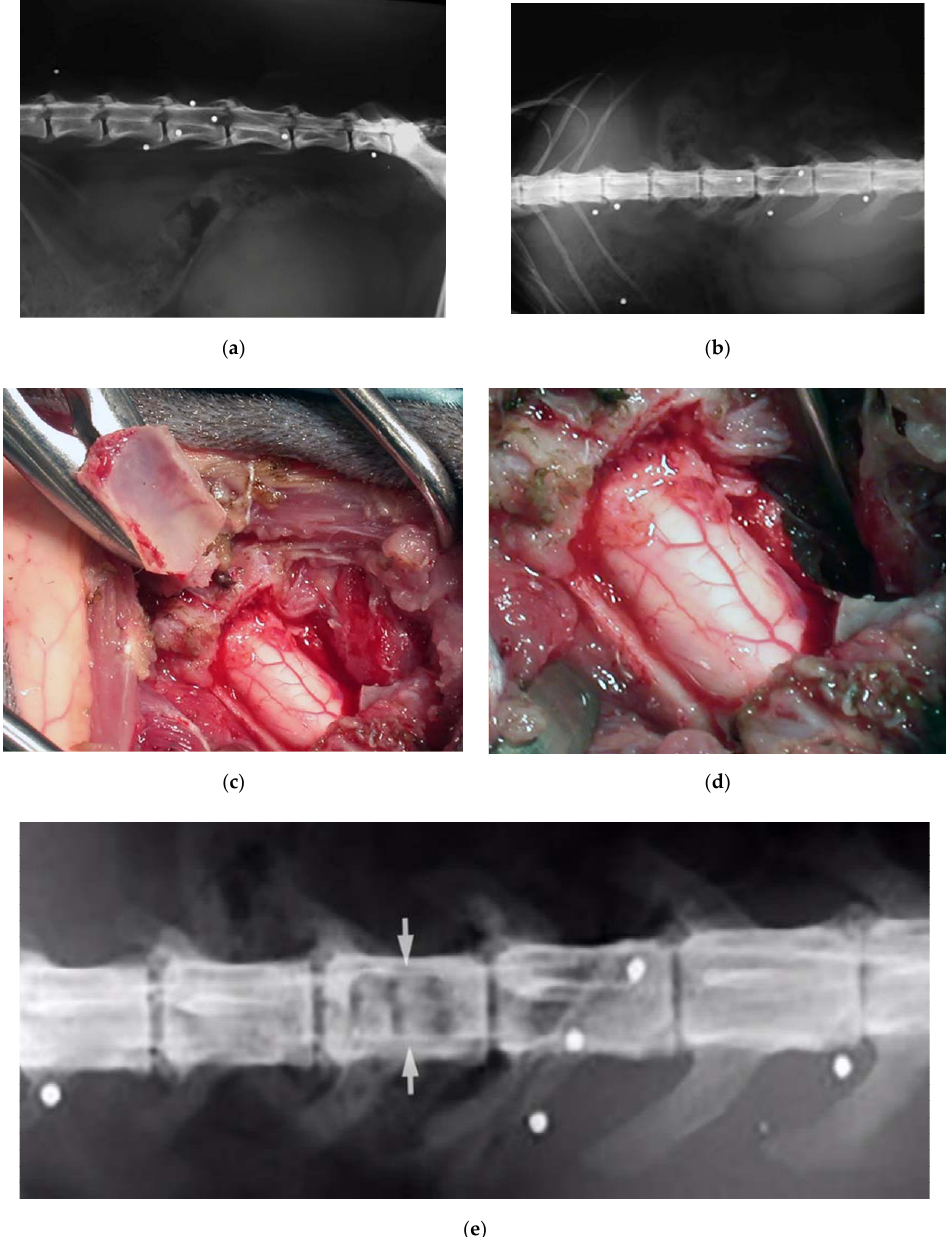
Figure 8. X-ray in latero-lateral ( a ) and ventro-dorsal ( b ) projection, showing multiple retained lead shots in a cat paraplegic because victim of a firearm trauma. One of the intrathecal lead shots caused a spinal cord contusion and partial compression. A subdural hematoma was also present. Intraoperative pictures showing lumbar spinal cord after decompressive one-level laminectomy performed with piezoelectric scalpel and an angled small saw tip (OT7S-3, Osteotomy Tips Kit, Mectron Medical Technology, Genoa, Italy) ( c , d ). Six-months postoperative ventro-dorsal X-ray showing the site of the laminectomy ( e